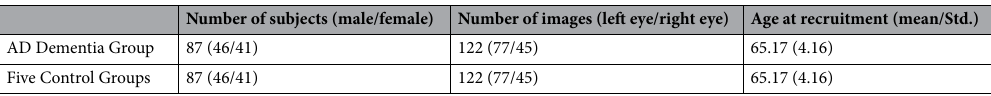
Table 1. Cohort characteristics of all extracted groups.